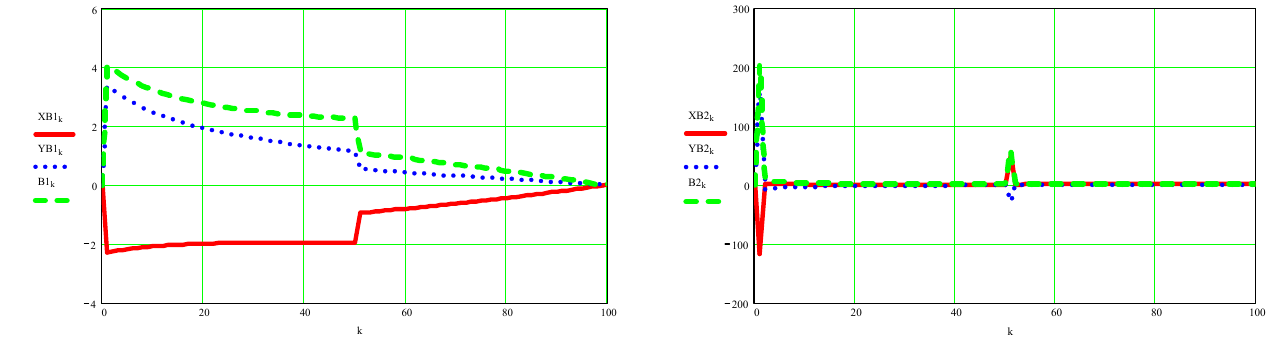
Figure A6. On the left side are the scalar coordinates of the speed of point B (red and blue) and its absolute speed (green); on the right the graphs of the accelerations of the same point B.